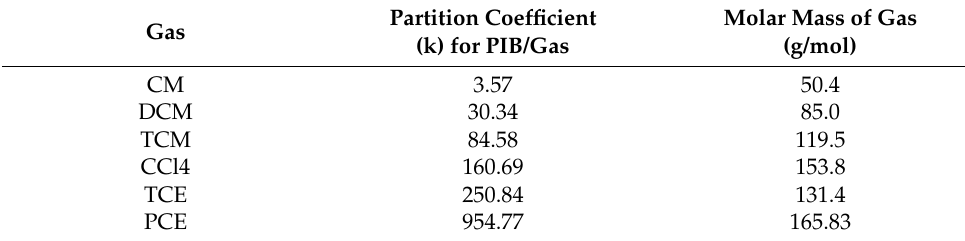
Figure 5. Electric field lines of ( a ) planar electrode and ( b ) fractal electrode.